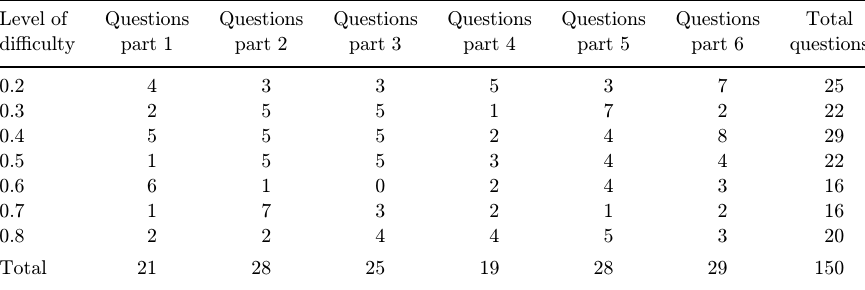
Table 2. Experimental data of small question